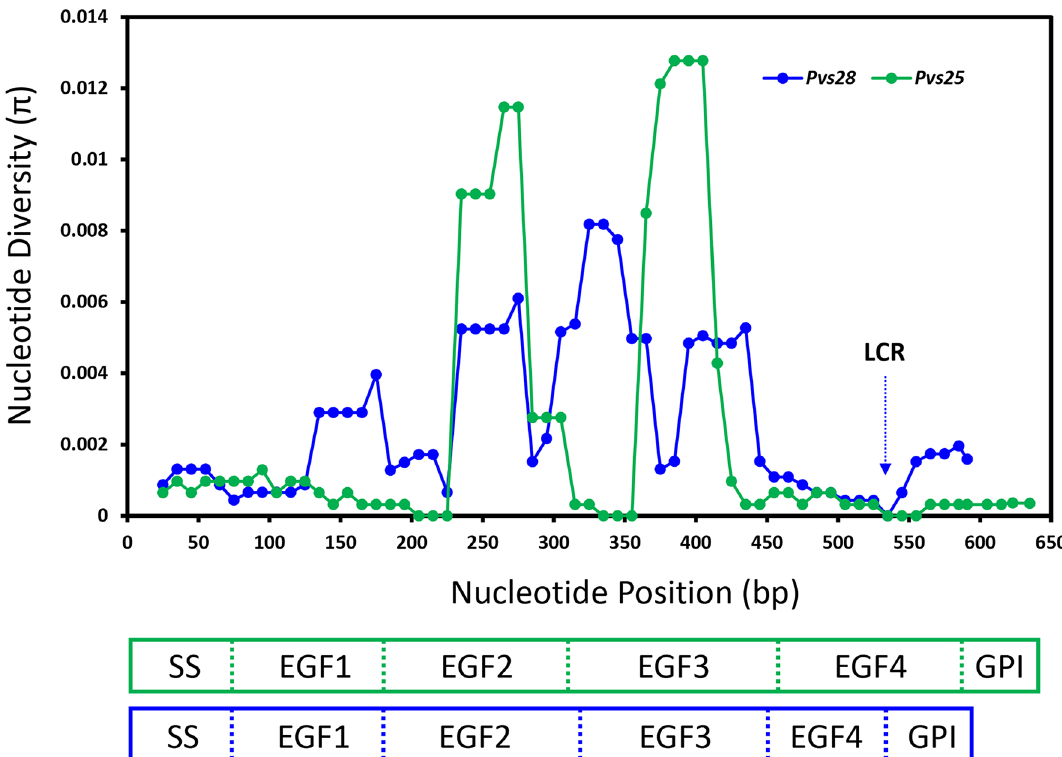
Fig 1. Sliding window analysis of the nucleotide diversity ( π ) on the pvs28 and pvs25 genes. Genetic diversity ( π ) was estimated using a sliding window of 50 base pairs (bp) with a step size of 10 sites. The LCR of tandem repeats of the pvs28 gene was not included but its location is indicated by a blue arrow.